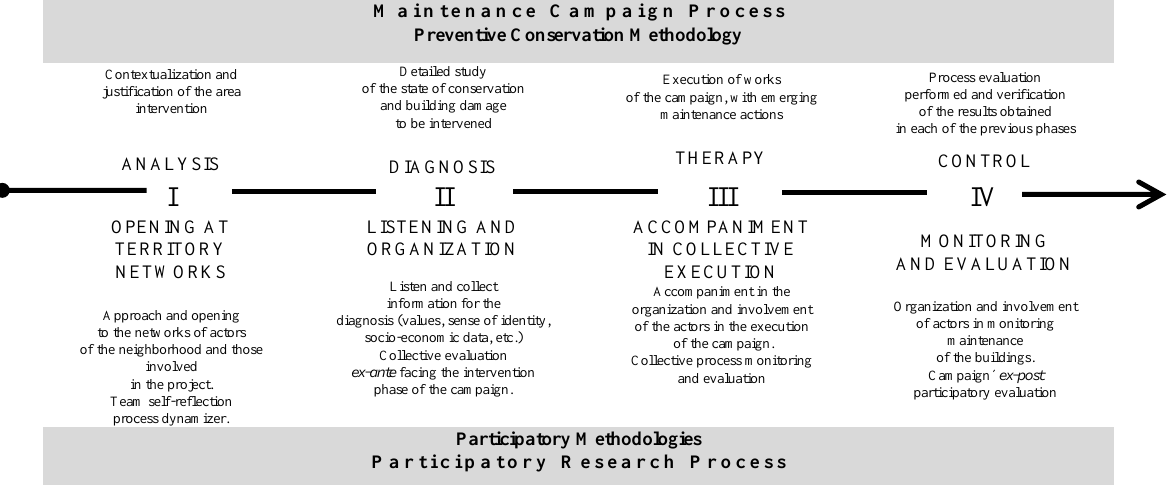
Table 2. Methodological articulation in the preventive conservation